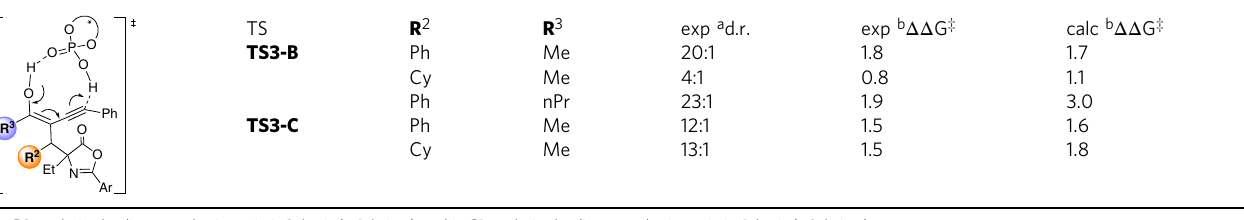
unfavorable TS3-B- SRS , which can be rationalized by the dihedral angle ∠ C1-C2-C3-H1 of forming hydrogen bond and allene as shown in Supplementary Fig. 8. The dihedral angle in TS3-B- SRS is 85.0°, which is more close to perpendicular than that in TS3-B- SRR